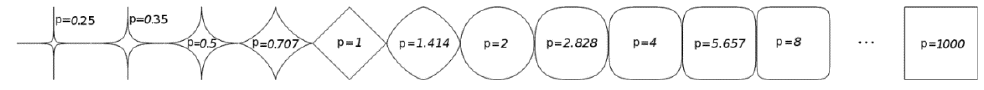
Figure 2. A circle on a plane at different values of the power coefficient p .